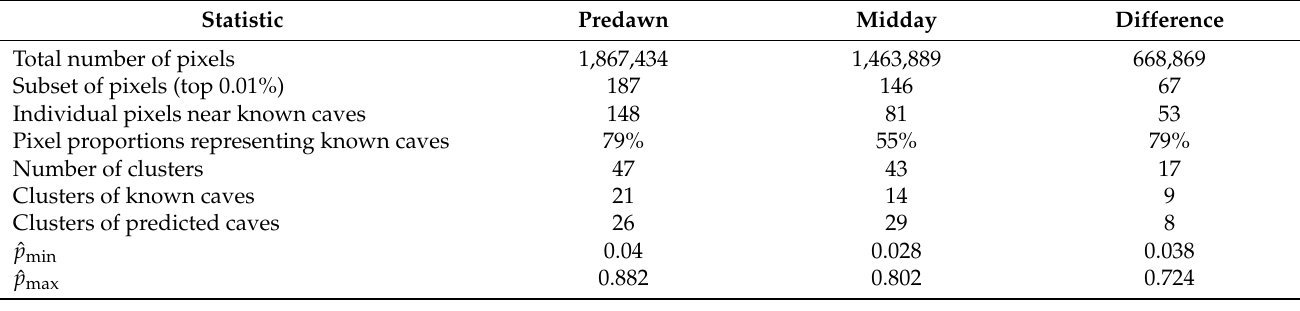
Table 2. Cluster statistics for Predawn, Midday, and Difference imagery types, Pisgah Lava Field, Mojave Desert, CA, USA. Total pixels per imagery type are provided. We arbitrarily selected the top 0.01% of pixels representing known and predicted caves. Clusters were defined as pixel aggregations where each pixel within a 2 m threshold distance of at least one other pixel was included within the cluster. These clusters were subdivided into clusters of known and predicted caves. Pixel ˆ p values represent the score for each pixel, which is based on the most parsimonious suite of predictor variables for each imagery type. Values range from 0 (lowest similarity to known caves; ˆ p min ) to 1 (highest similarity to known caves; ˆ p max ).